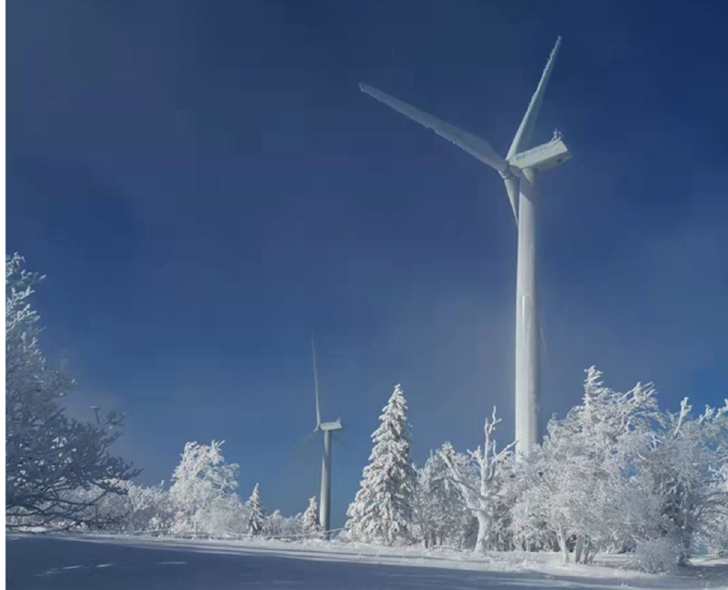
Figure 1. Examples of icing on wind turbines.